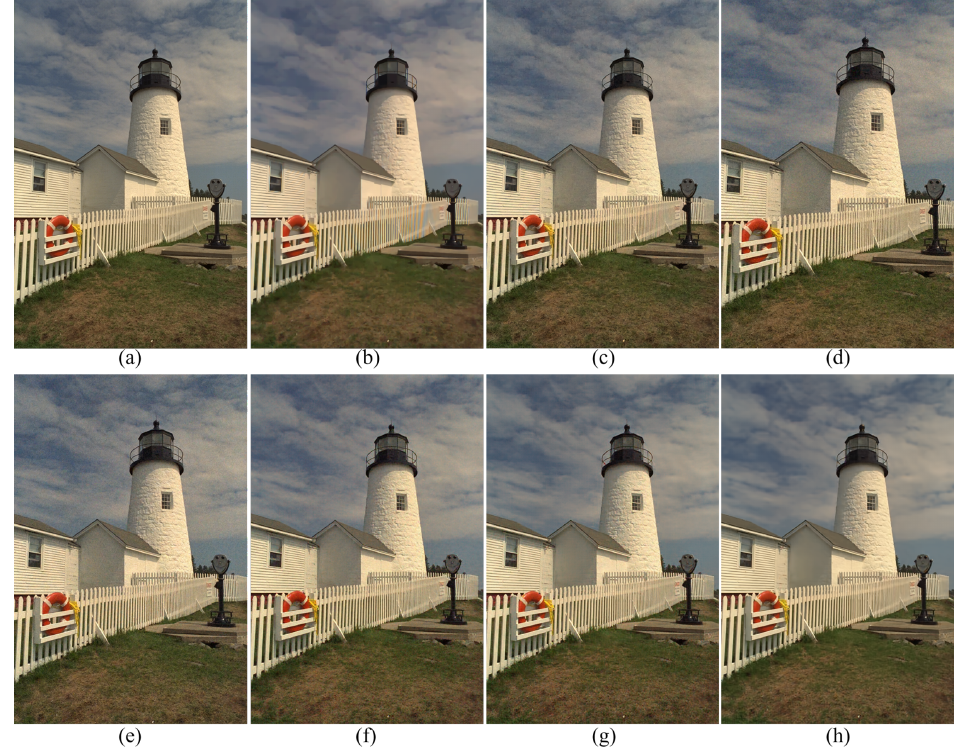
Figure 3. Reconstruction results for the Kodak number 19 image with noise levels σ R = 9.83, σ G = 6.24 and σ B = 6.84. ( a ) Original, ( b ) ADMM, [28] ( c ) SEM, [14] ( d ) DNetB, [15] ( e ) DNetX, [15] ( f ) DIP, [19] ( g ) proposed and ( h ) proposed +